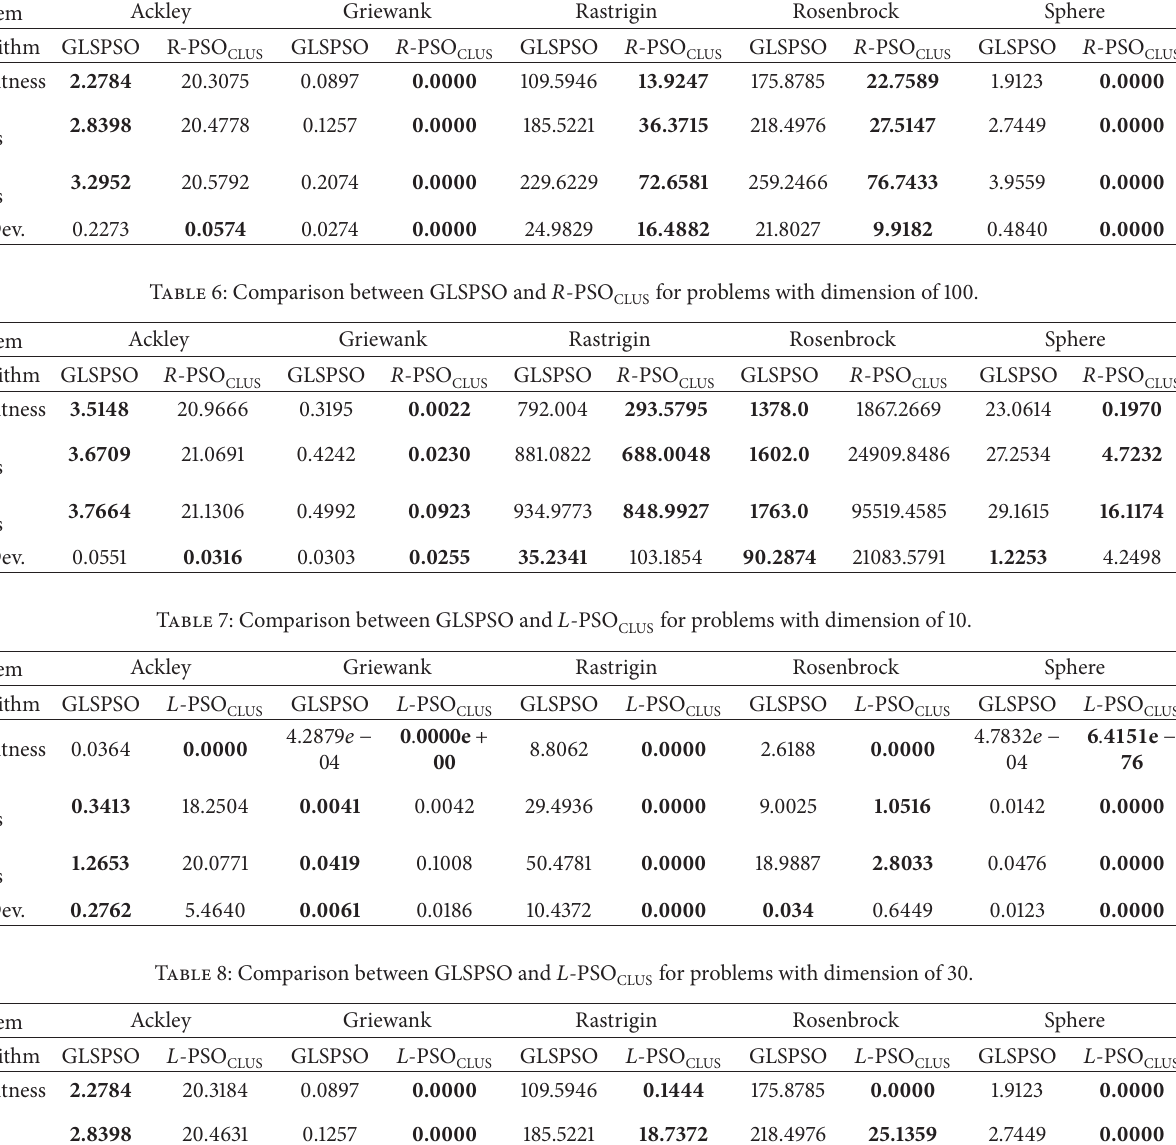
Table 5: Comparison between GLSPSO and 𝑅 -PSO